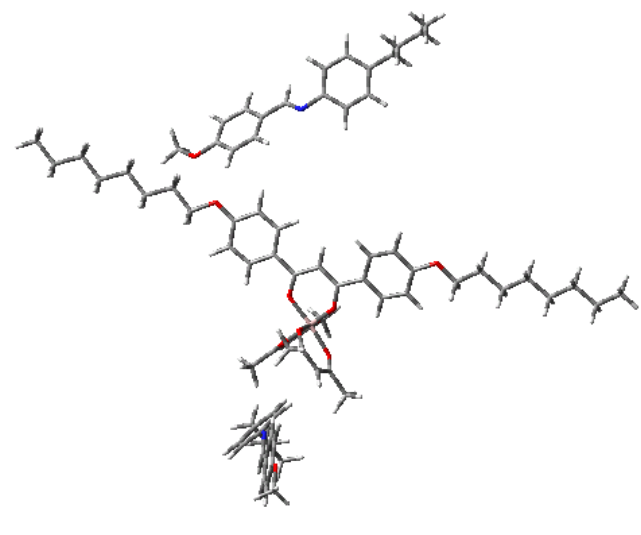
Figure 1. The energy-minimized structure of [ Δ - [ Al(acac) mutually left-handed orientation of two MBBA molecules. This figure is a modified version of the one from reference